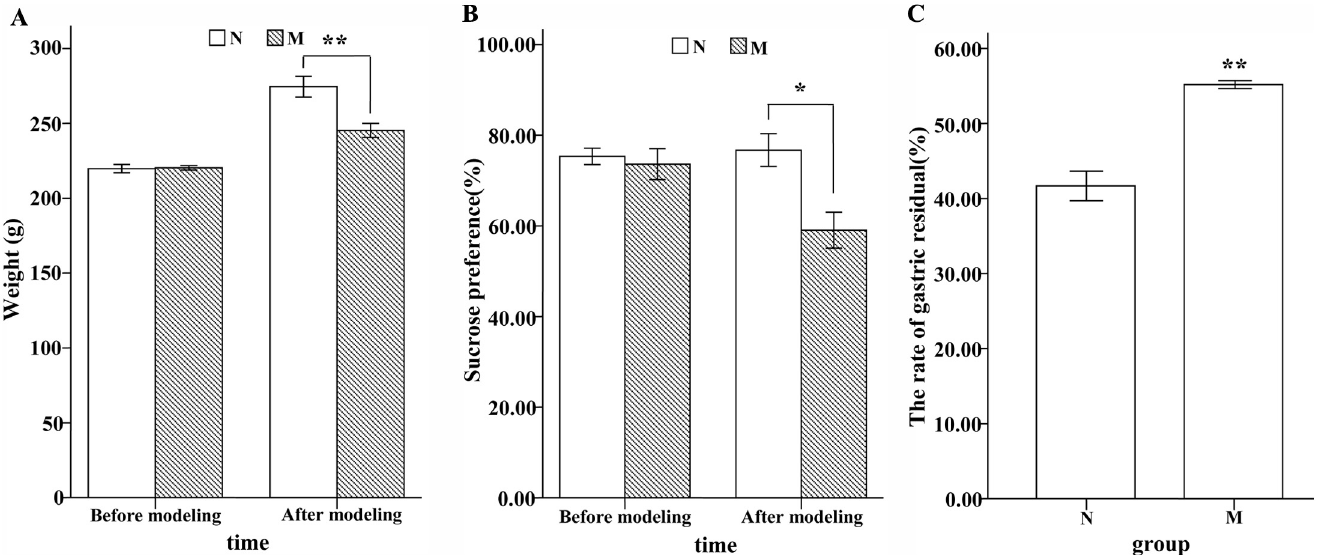
Fig 1. Rats show depressive-like symptoms at the end of the experiment. (A) Body weight. (B) Percentage of sucrose solution from the total liquid in sucrose preference test. The results of the percentage were 59.05 ± 3.97 in group M and 76.73 ± 3.60 in group N. (C) The rate of gastric residual. The results were 55.18 ± 0.52 in M and 41.68 ± 1.97 in N.